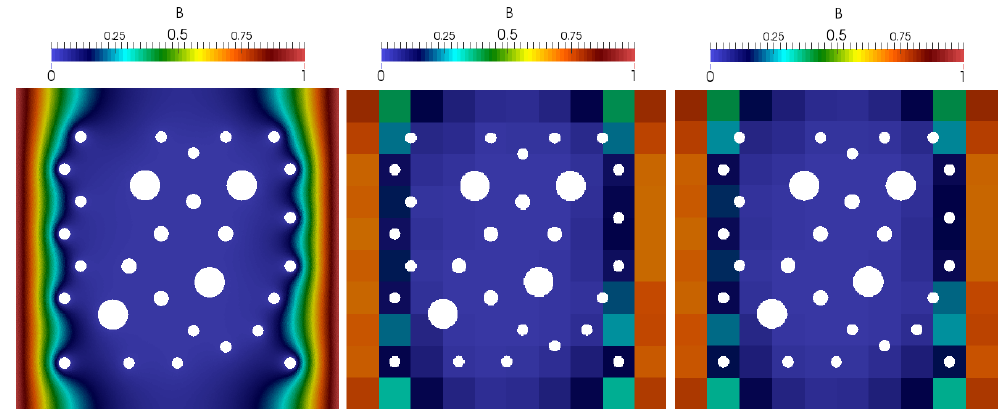
Figure 5. The distribution of the magnetic field. ( Left ): Reference (fine grid) solution, DOF f = 155,580. ( Center ): Cell average for reference (fine grid) solution. ( Right ): Multiscale solution, DOF c = 980 (0.48% from DOF f